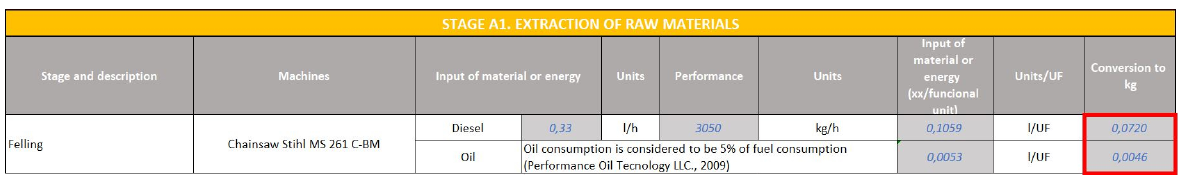
Figure 1. Spreadsheet development of one of the processes for 1 m 3 of laricio pine sawn timber